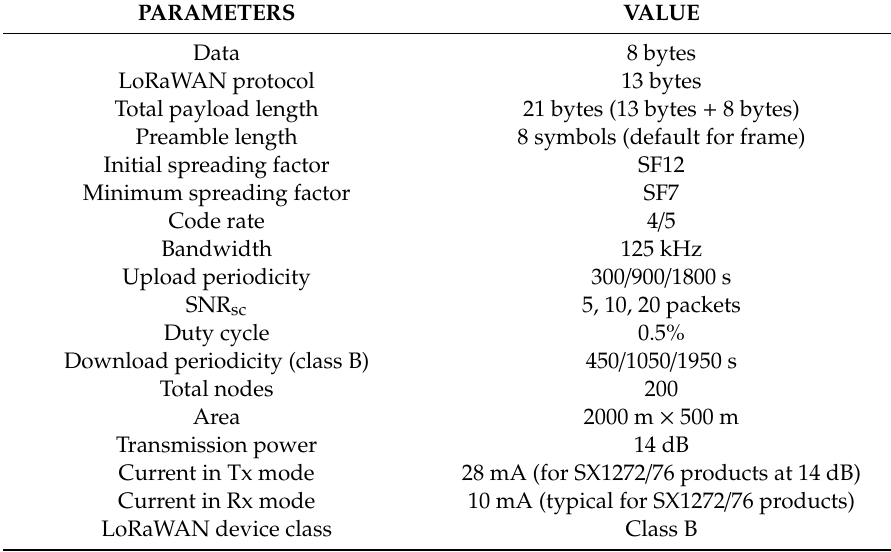
Table 4. Simulation parameters.